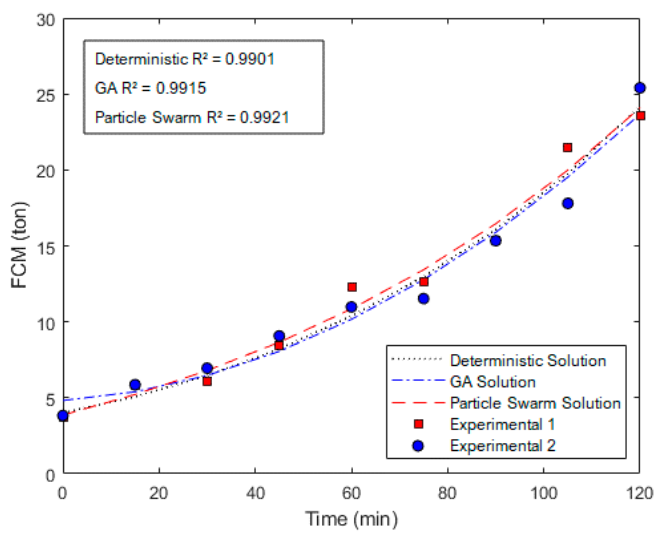
Figure 5. Model results—formed crystal mass (FCM).